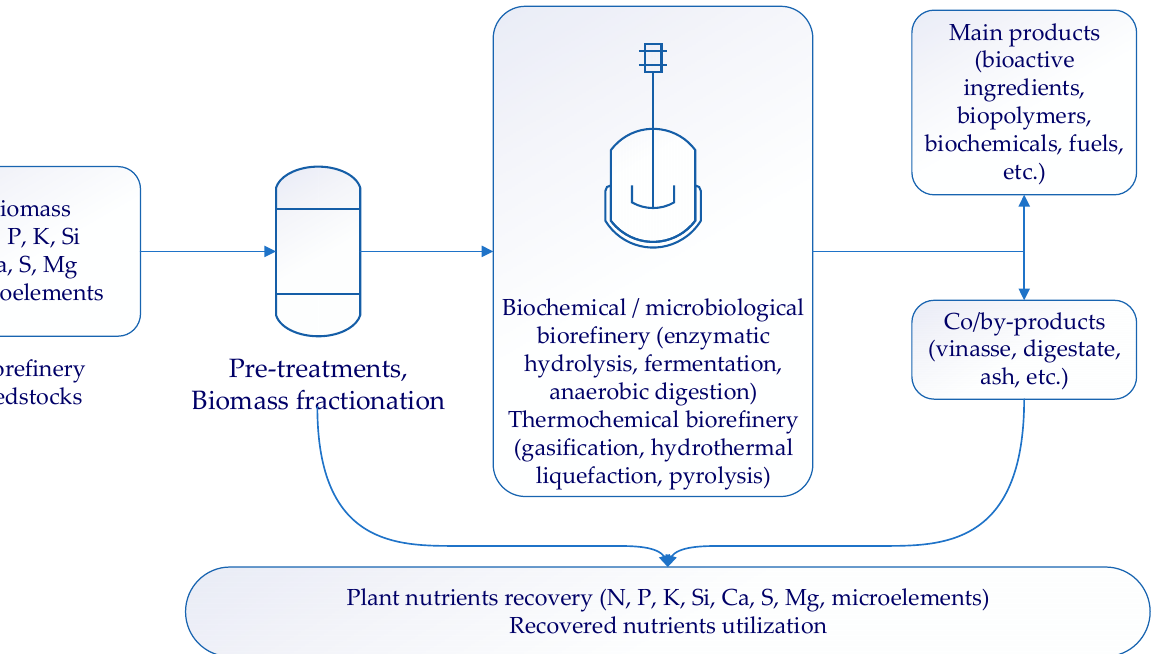
Figure 1. Ilustration of the dual goal followed in this work: nutrient recovery solutions during the biorefinery processes and recovered nutrients utilization.